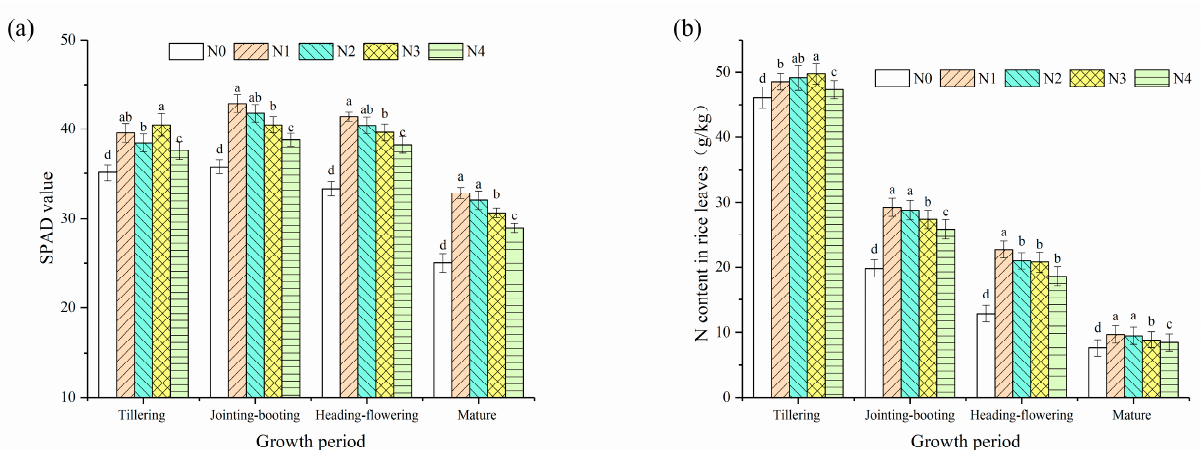
Figure 1. Effect of N forms on soil and plant analyzer development (SPAD) value and leaf N content of rice seedings. ( a ) SPAD value of rice leaf and ( b ) N content of rice leaves. Vertical bars indicated the standard error. Different letters with the same growth period indicated significant differences at p < 0.05 according to the Duncan’s test. Tillering means tillering stage; jointing–booting means jointing–booting stage; heading–flowering means heading–flowering stage; mature means mature stage.